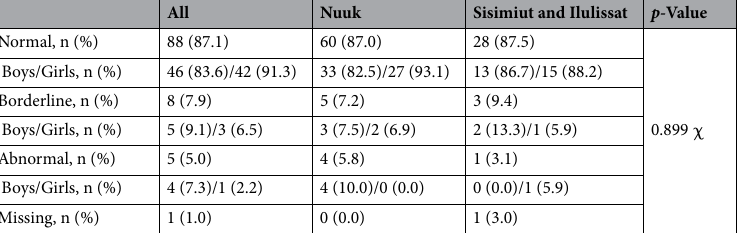
Table 2. Child characteristics: Greenlandic children born 2014–2016 in the ACCEPT birth cohort. N total number of participants, n number of participants with information on the variable, τ: p -Value was calculated with T-test on ln-transformed data, χ : p -Value was calculated with Chi-square test for locations, Bold text and * = Significant ( p ≤ 0.050), Bold text and ** = Borderline significant ( p ≤ 0.100), Missing % was calculated on the basis of all responders and